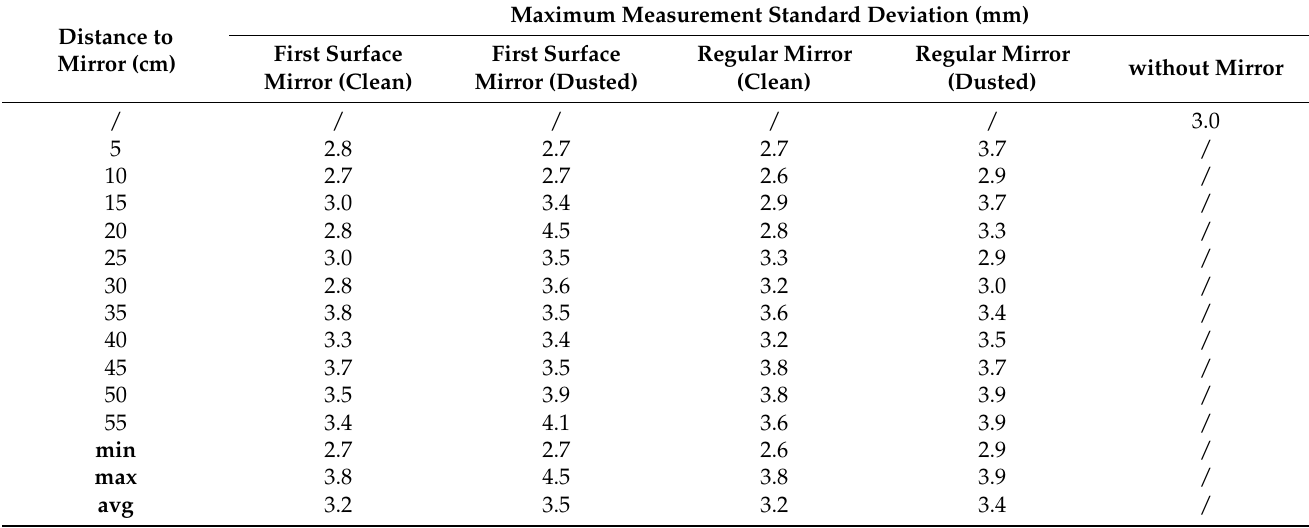
Table 1. Maximal measurement standard deviations in various